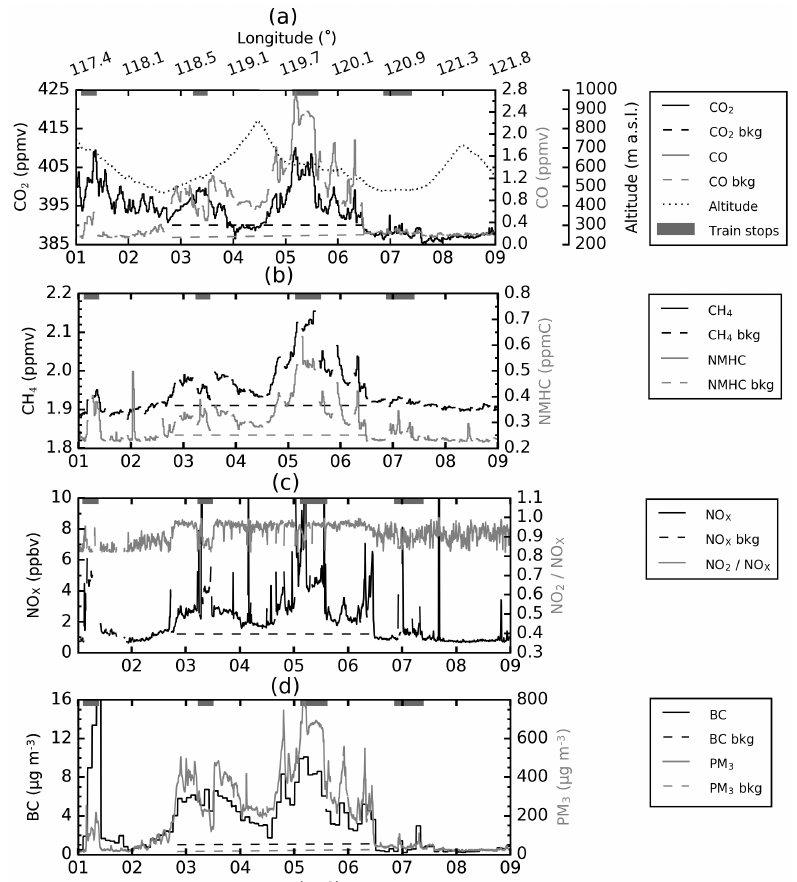
Figure 3. Measured 10s trace gas mixing ratios and aerosol mass concentrations observed in the vicinity of the F1 forest fire plume during TROICA-09 expedition on 9 October 2005. Local time is UTC +